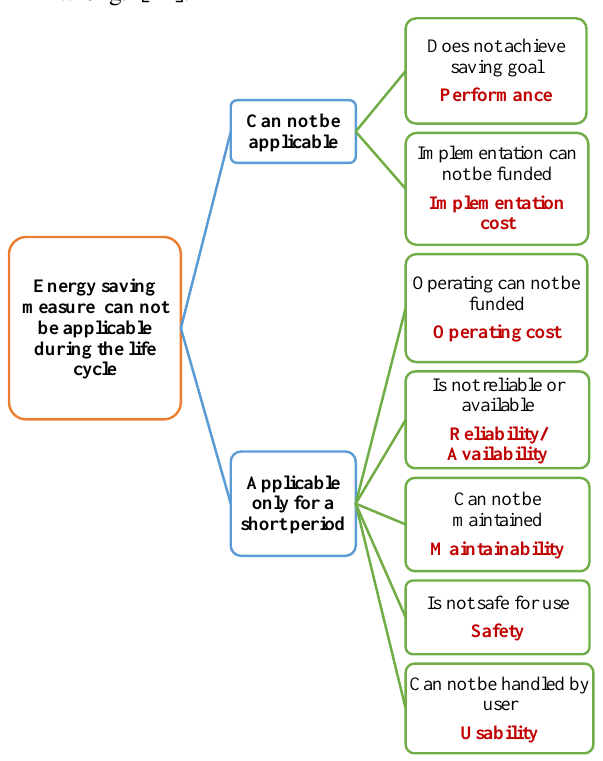
Figure 3. Energy-saving measures selection criteria by fault diagnosis method Table 1. Pair-wise comparison matrix of criteria for energy-saving measures